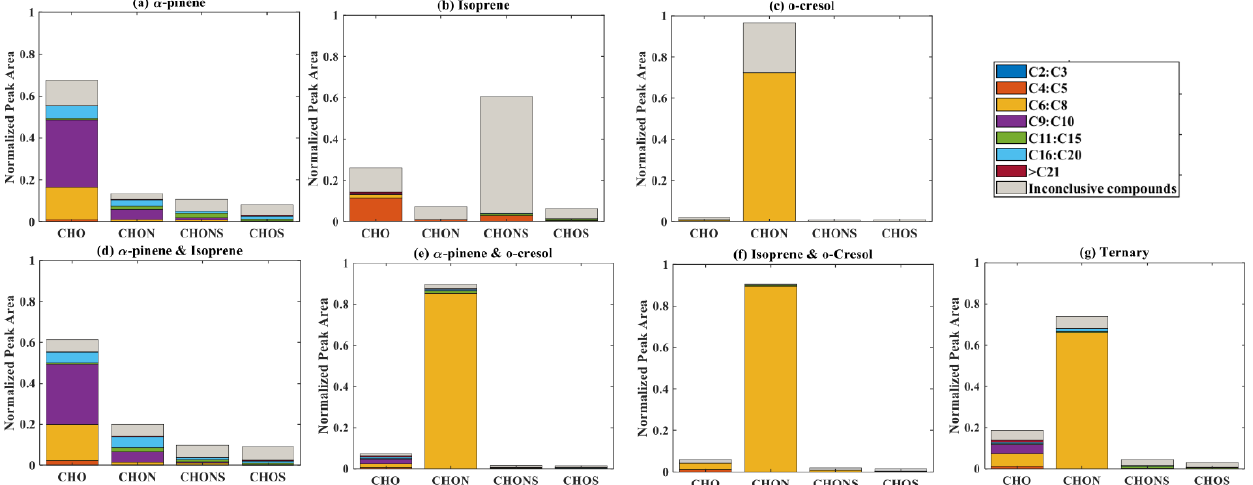
Figure 4. The normalized signal intensity distribution of different compound categories (CHO, CHON, CHOS, and CHONS) for various sin- gle and mixed precursor systems in negative-ionization-mode ESI (–) by LC-Orbitrap MS. The grey bar (inconclusive compounds) indicates the signal attributed to compounds that were not universally found in all repeat